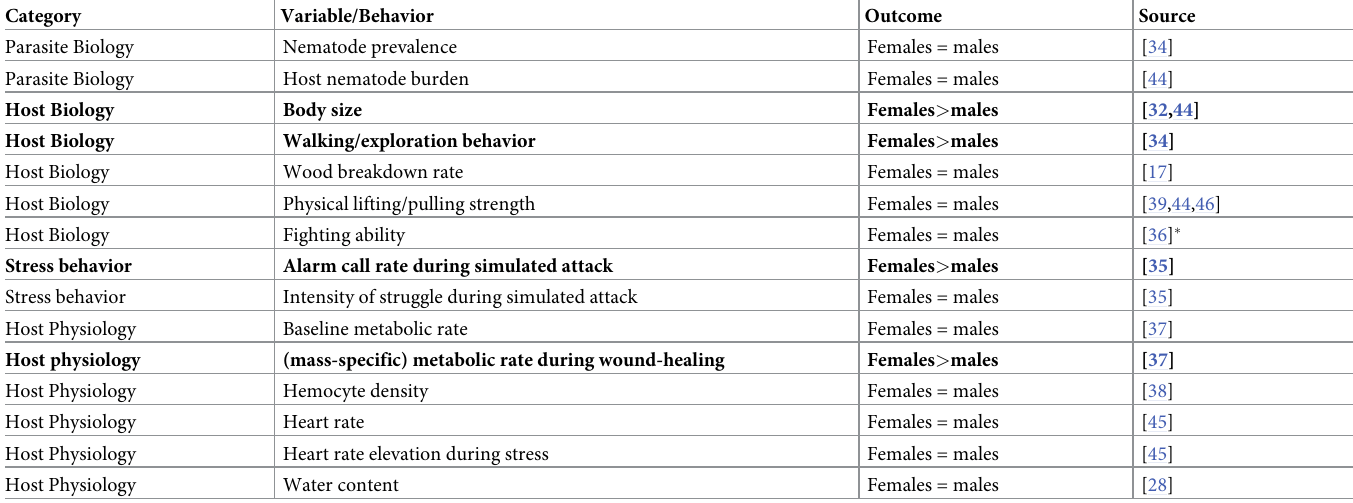
Table 3. Summary of all known male-female differences in behavior, physiology and parasitism in horned passalus beetles, Odontotaenius disjunctus .